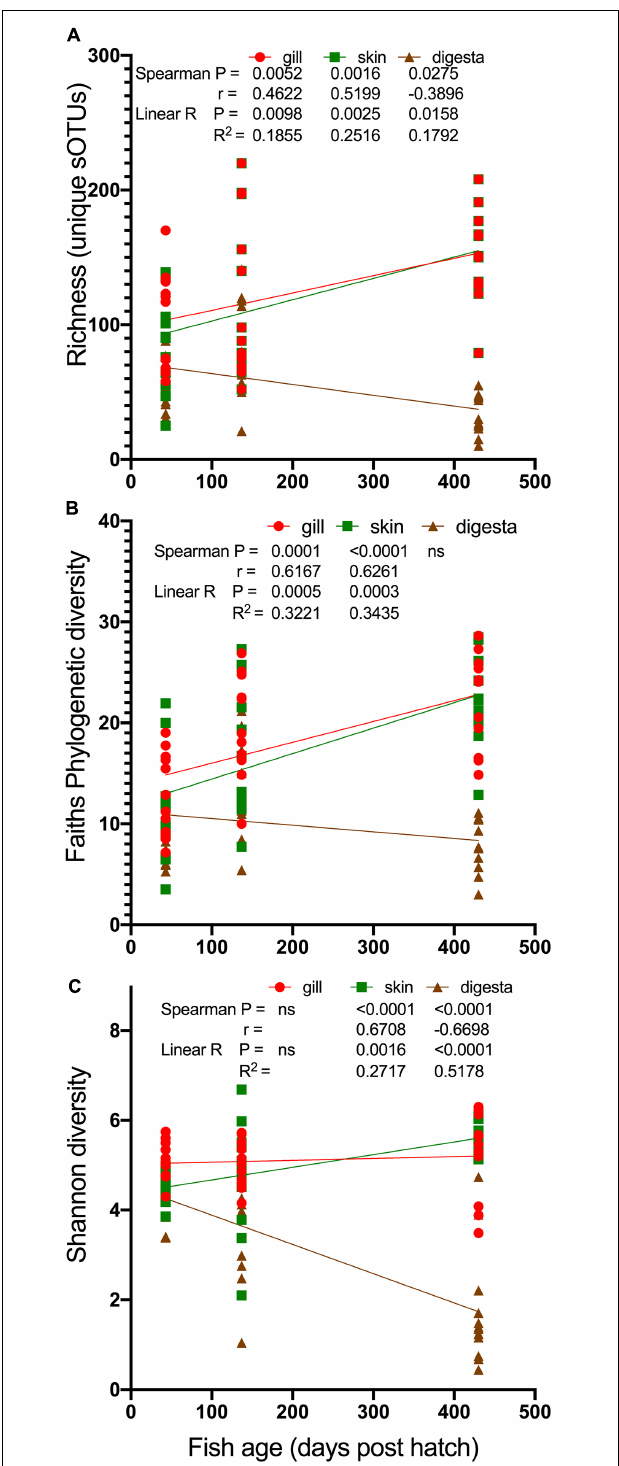
FIGURE 3 | Modeling of changes in alpha diversity: (A) richness, (B) Faiths PD, and (C) Shannon diversity over the age of the fish. Only fish reared in indoor systems included (430 dph seapen fish excluded). Statistical comparisons of both Spearman correlation and linear model (linear regression) calculated with results depicted on the